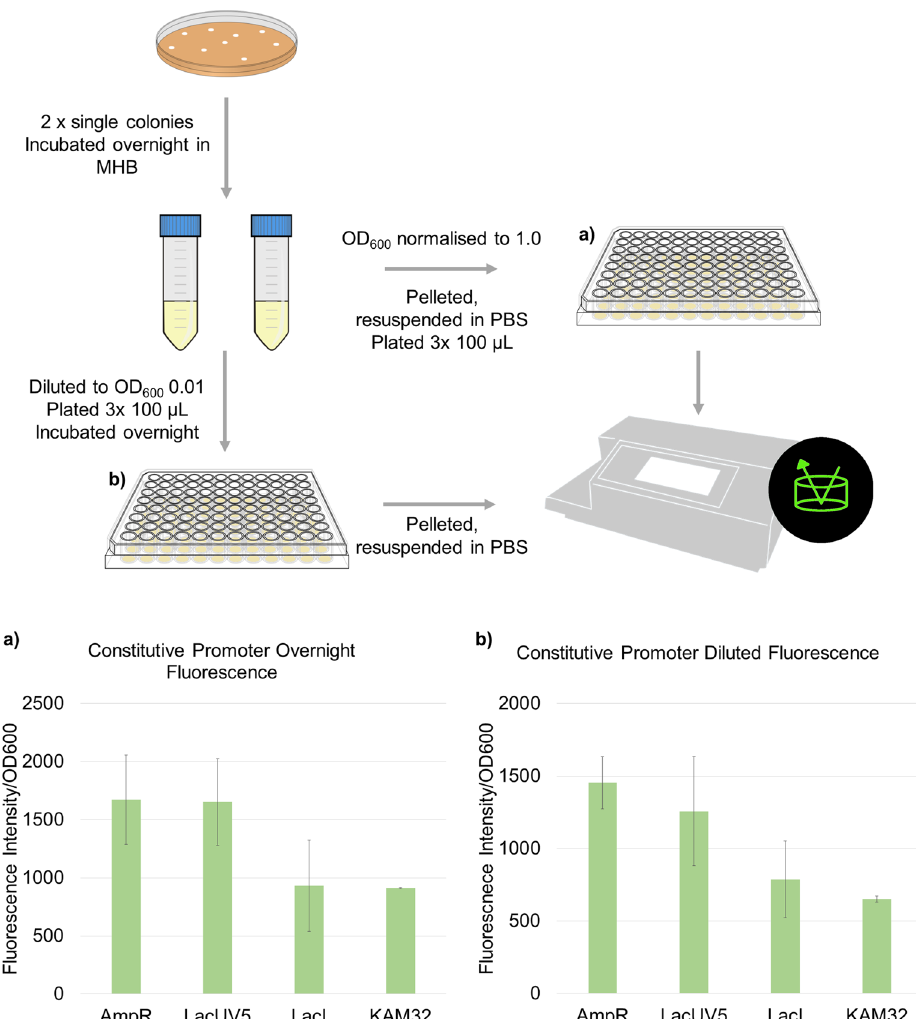
Figure 5. Fluorescence intensity of E. coli KAM32 cells containing sfGFP under the control of three constitutive promoters: AmpR, LacUV5 and LacI. Fluorescence was measured after incubation at 37 °C for 18 h ( a ), or after dilution of that culture to OD 600 0.01 and further incubation for another 18 h ( b ). Averages and standard deviations of two transformations, each with three technical replicates, are shown.